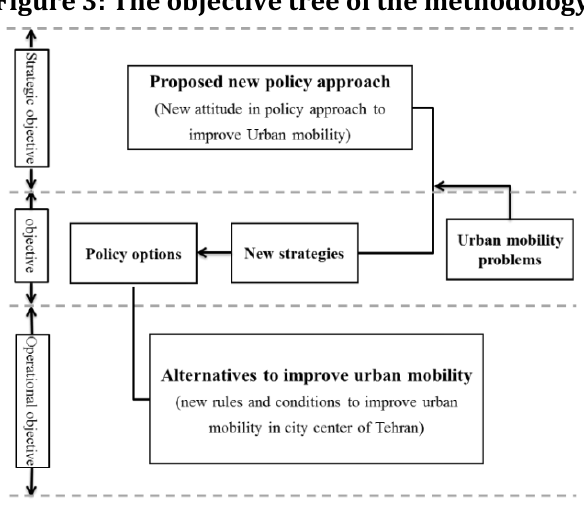
Figure 3: The objective tree of the